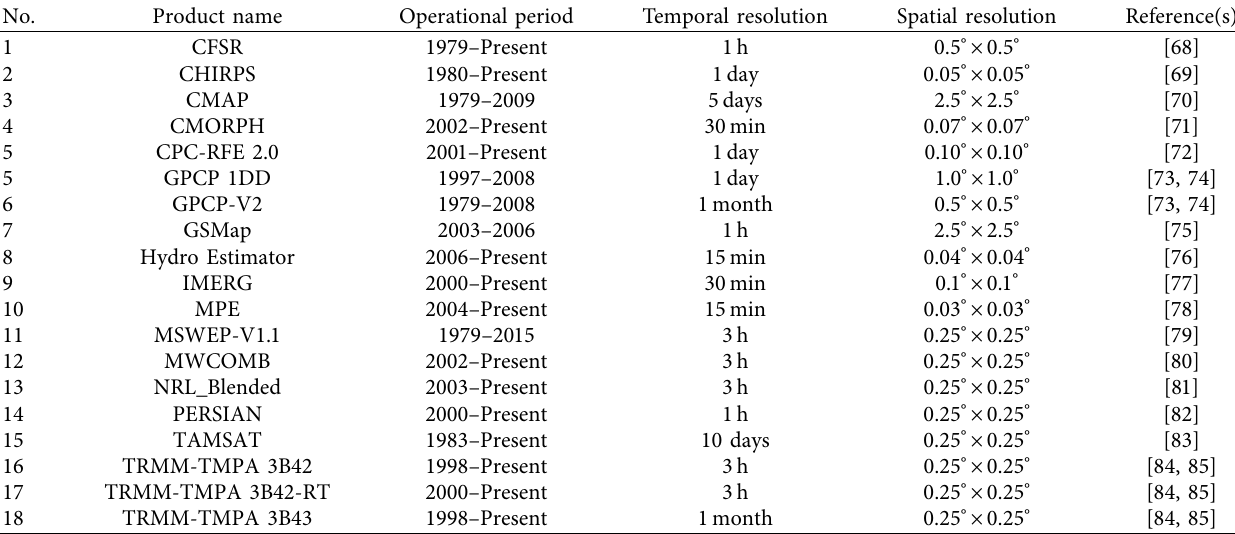
Table 2: Common satellite rainfall products for rainfall estimation (source: [67]).